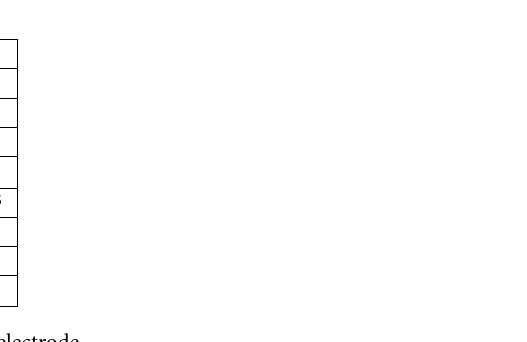
Table 1. Modelling parameters for the platinum